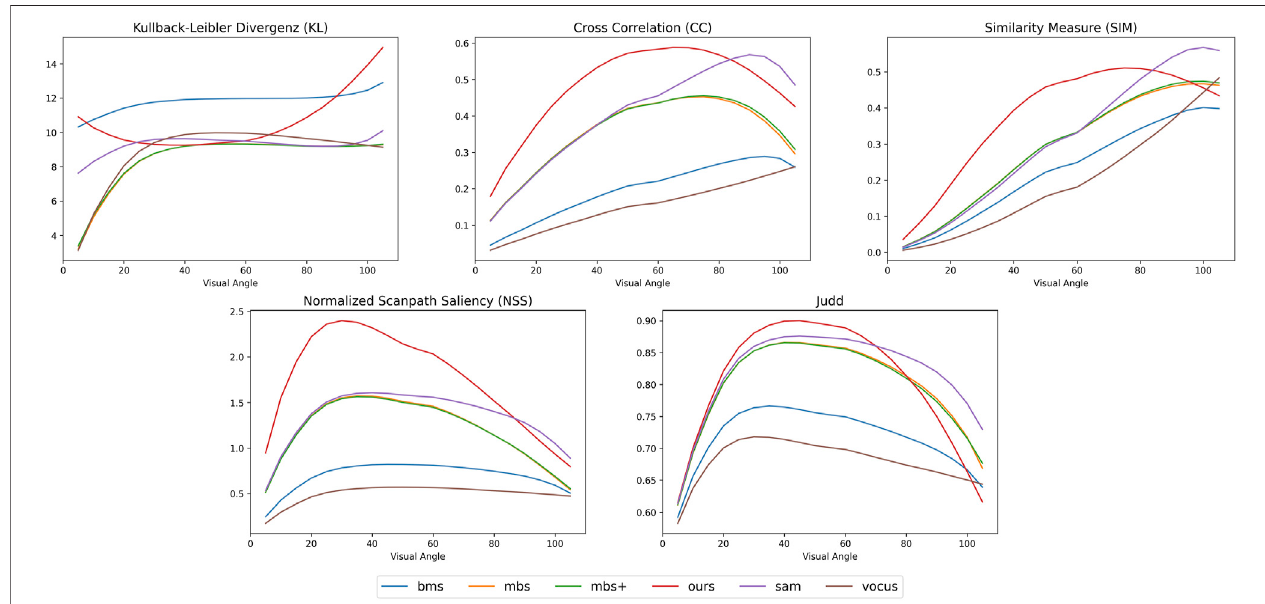
FIGURE 6 | Graphs showing the results measured on the Saliency in VR dataset with different fi eld of view angles to simulate different VR headsets and viewing conditions. The fi gure shows the accumulated measurements over our extracted subset of the dataset mentioned in Section 4.1 . This subset contains 4 different omnidirectional images containing 137 videos totaling an amount of approximately 500k frames. Section 4.2 explains the shown metrics in detail.